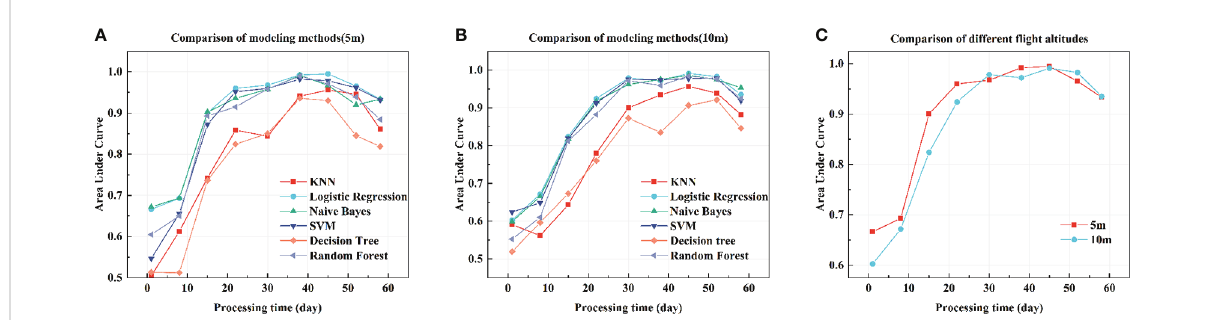
FIGURE 6 Different modeling algorithms and AGL evaluation. AUC is the evaluation metric of the model as the average of area of the ROC curves for each classi fi cation sample. (A) performance evaluation of different algorithms at 5 m AGL, (B) evaluation of different algorithms at 10 m AGL, (C) evaluation of logistic regression algorithms at different